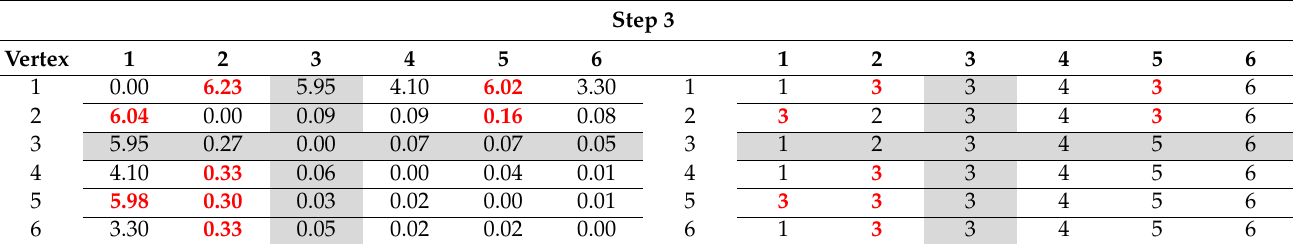
Table A12. The step 3 graphical process of the best search and rescue route.